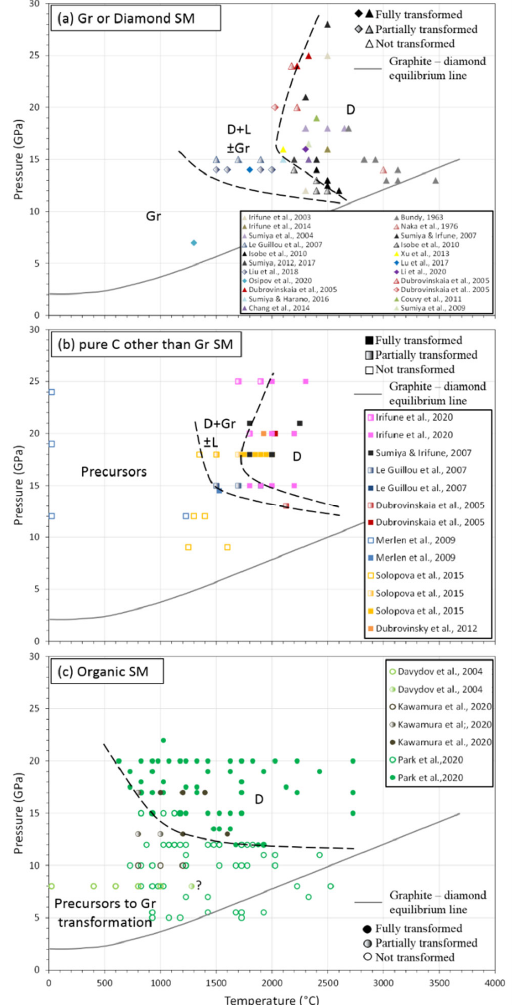
Figure 8. Pressure–Temperature diagram and data compilation of direct transformation of carbon compounds to diamonds at high pressure and high temperature. SM is for starting materials, C for carbon, Gr for graphite, L for lonsdaleite and D for diamond. Filled symbols are for total conversion to diamonds; open symbols are for no transformation; and color gradient is for incomplete, i.e., with SM remaining or for the presence of L in the sample. Triangle and diamonds are for Gr and D SM ( a ), square for other than Gr or D pure carbon SM ( b ), and circles are for organic compounds as SM ( c ). Grey solid line is for the graphite–diamond equilibrium as defined in Figure 5. Black dashed lines are guide for the eyes to note the transition to diamond. It is of note that this transition is favored with organic compounds ( c ) compared to other pure C form ( b ) and to graphite precursor ( a ). Additionally, lonsdaleite appears with pure carbon precursors and seems to be more present with higher crystallinity graphite (see text for more details). References: ( a ) [5], Irifune et al., 2003; [56], Bundy, 1963; [102], Irifune et al., 2014; [110], Naka et al., 1976; [122], Sumiya et al., 2004; [123], Sumiya & Irifune, 2007; [124], Sumiya & Irifune, 2008; [125], Le Guillou et